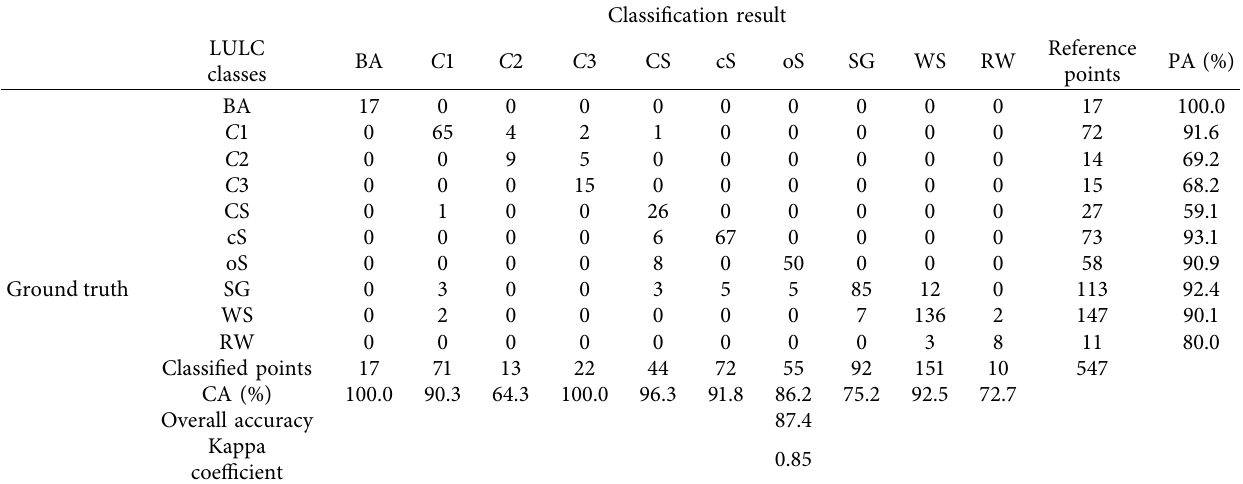
Table 3: Accuracy assessment MATRIX for LULC